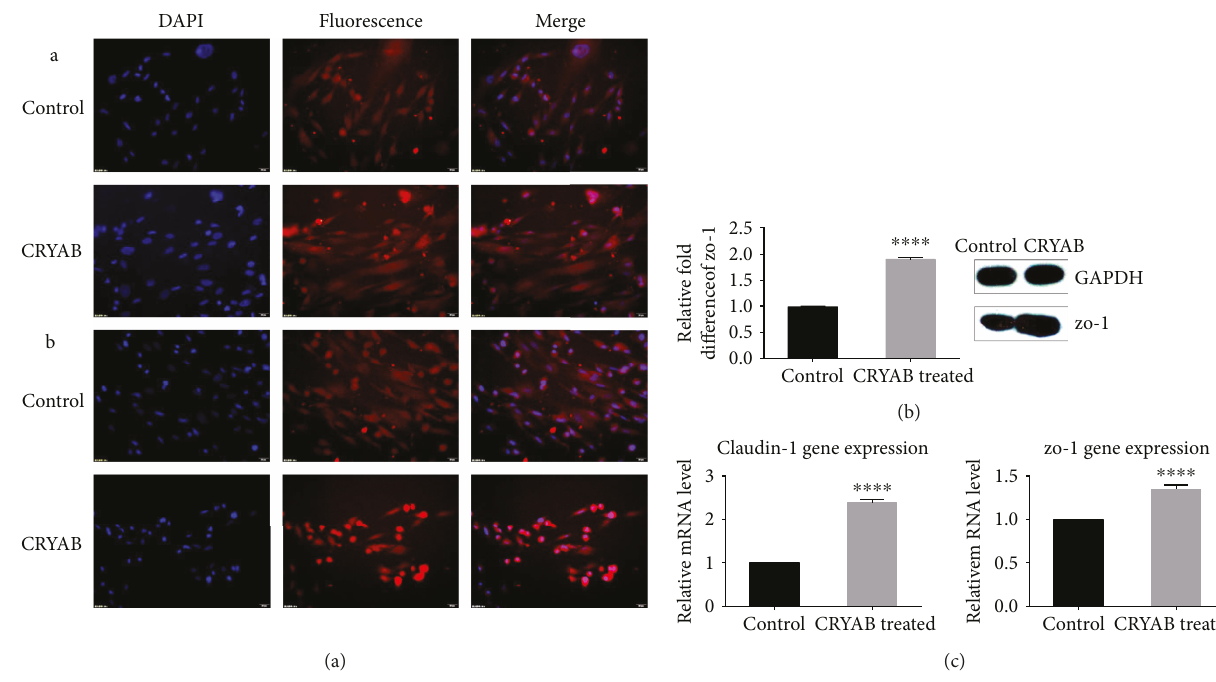
Figure 4: E ff ect of CRYAB on the expression of zo-1 and claudin-1 in TM cells. (a) Immuno fl uorescence manifestation of zo-1 and claudin-1. Immuno fl uorescence veri fi ed the upregulation of tight junction proteins (A: zo-1; B: claudin-1). (b) Western blot analysis of zo-1 expression. TM cells were exposed to 10 ng/ml CRYAB for 24 h. The expression of zo-1 increased under CRYAB conditions compared with the control. (c) Rt-qPCR analysis of zo-1 and claudin-1 mRNA expression. Compared with that of the control, the expression of zo-1 and claudin-1 was upregulated in response to CRYAB. The data represent the mean ± SD of three independent experiments. ∗∗∗∗ p < 0 0001 versus the